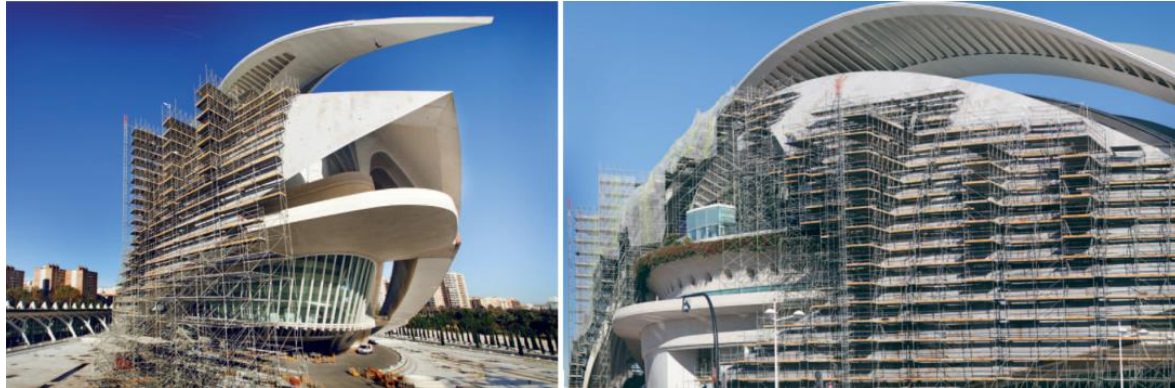
Figure 6. Palau de les Arts Reina Sofia, Valencia (2005). The scaffolding system used for the replacement of the trencadís. Reprinted with permission from ref. [36]. Copyright 2018 Ulma Construction .